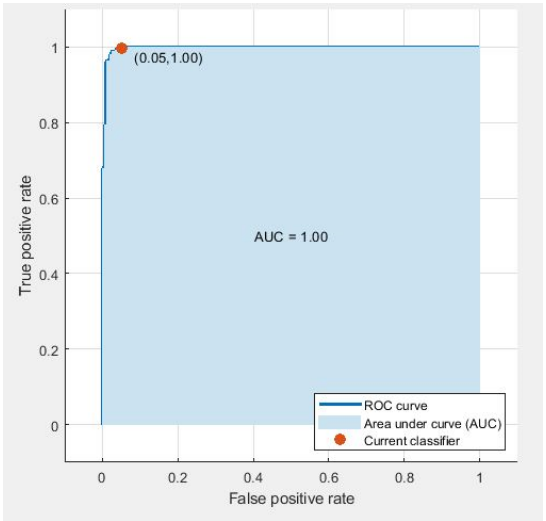
Figure 8. ROC curve using parallel fusion using 10-fold classification o LSVM. Confusion matrices for 10-fold cross-validation using the f 3 vector are visualized in Figures 9–12.